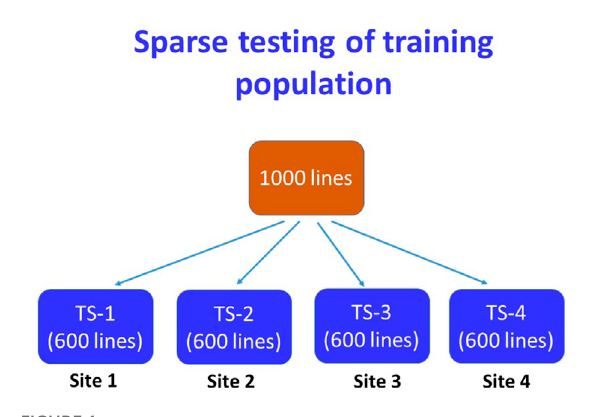
FIGURE 1 A scheme of sparse testing of training population for the genomic selection followed for the irrigated ecosystem. In this scheme, 40% of lines of the breeding population are common in all four TPs and the remaining lines were sampled by 25% at each time avoiding duplication among the